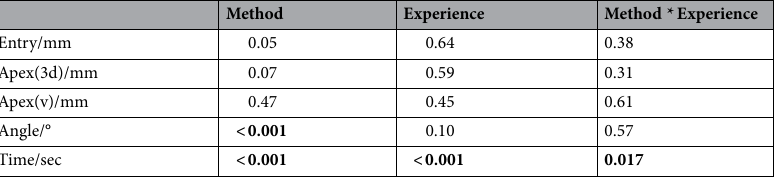
Table 2. Statistical significance of implant deviation and time considering approach, experience, and interaction of both. Numbers in bold refer to statistically significant